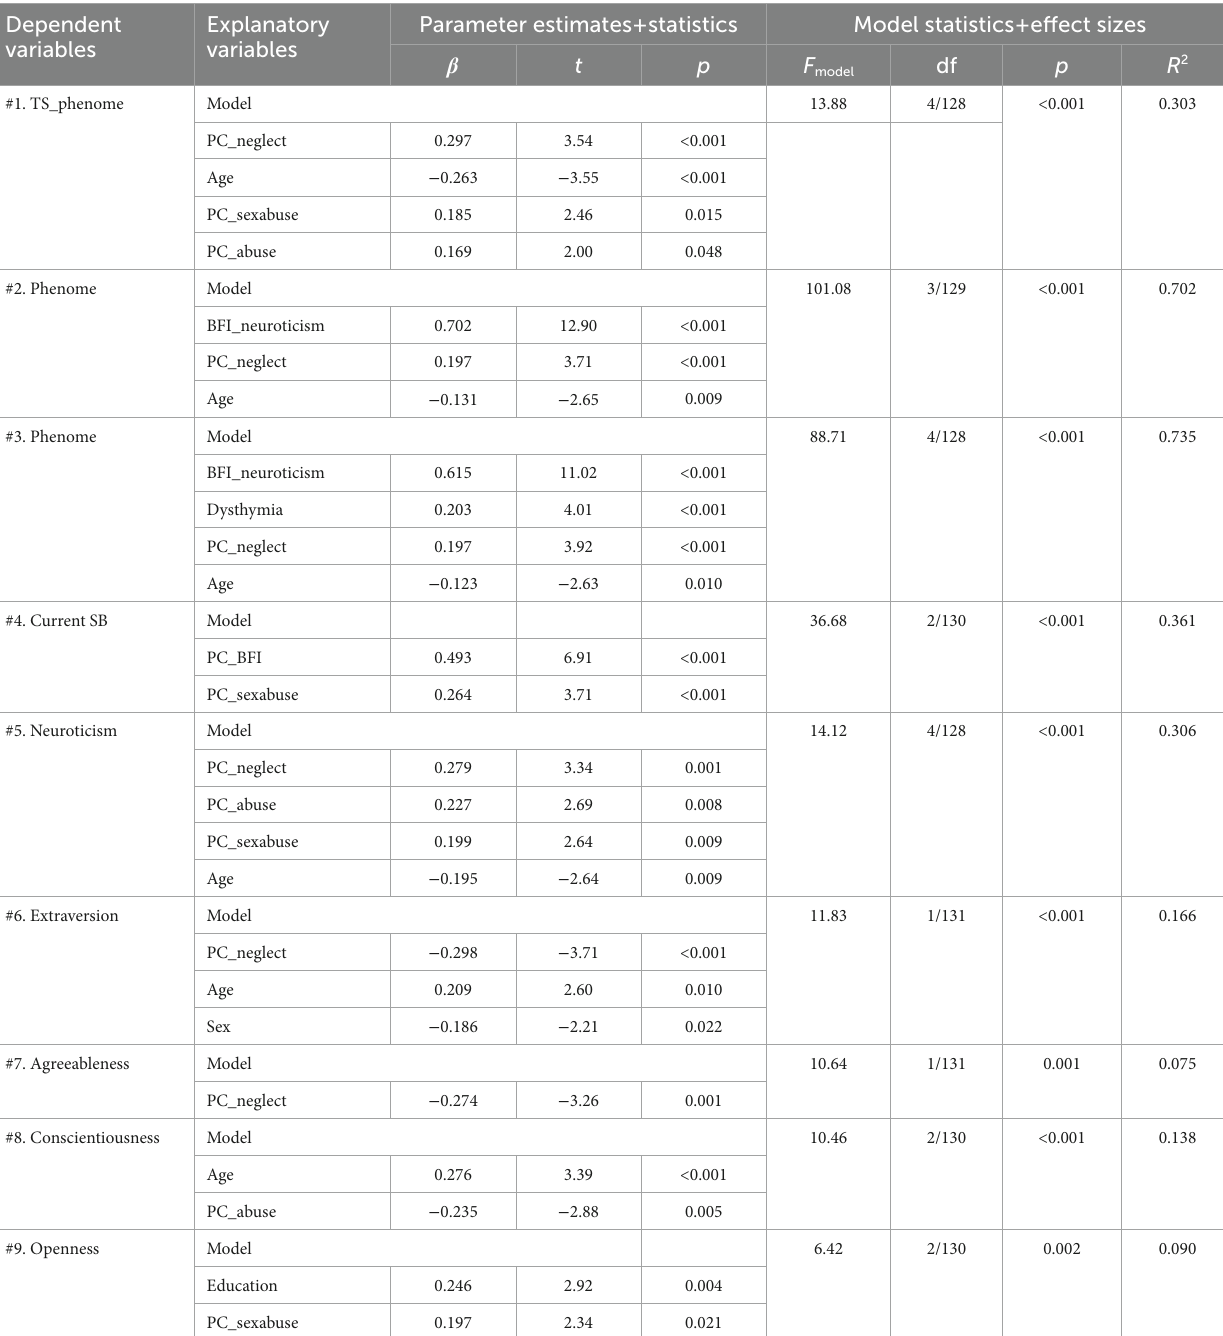
TABLE 5 Results of multiple regression analyses with phenome data and personality domains as dependent variables and adverse childhood experiences as input variables. Dependent